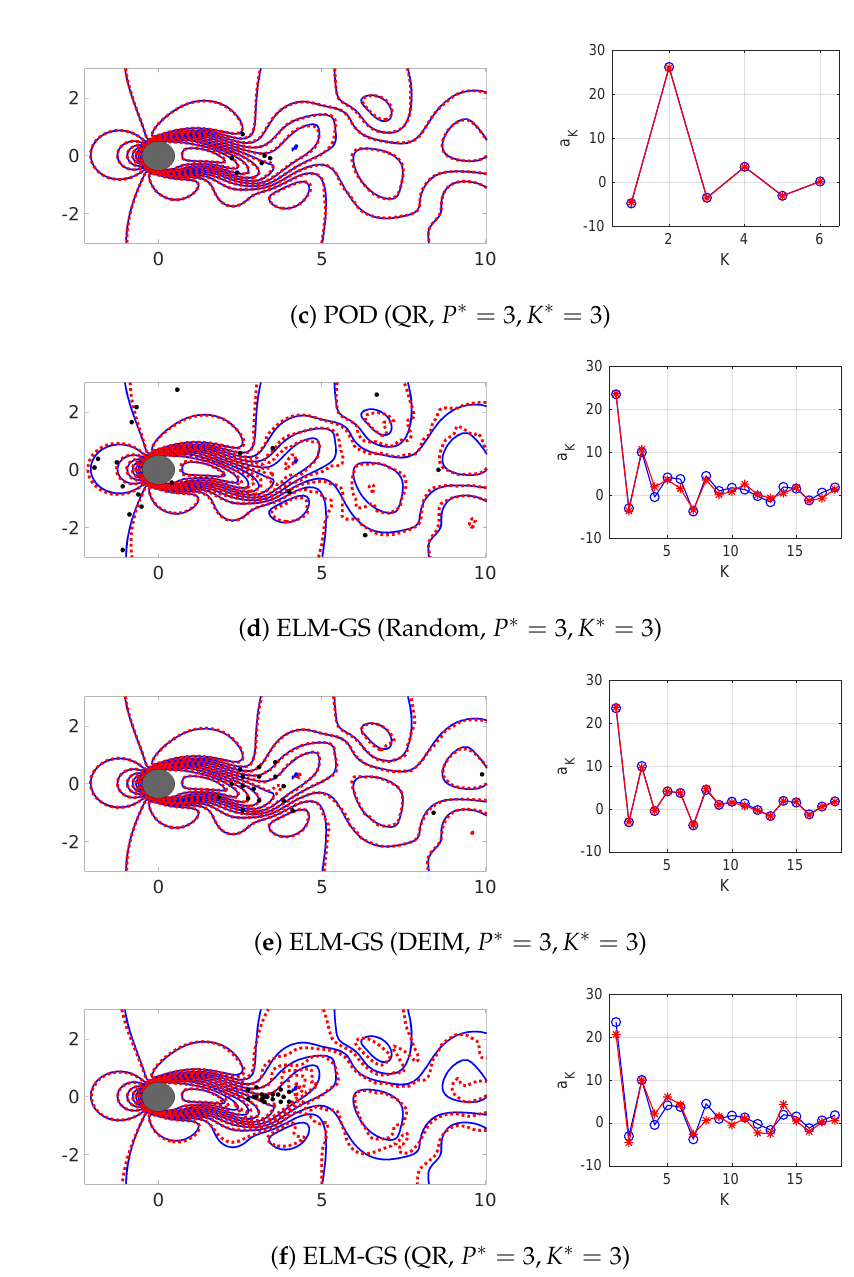
Figure 15. Left column: Comparison of line contours of streamwise velocity between the true flow field (blue) and SR reconstruction (red) for Re = 100 using random and DEIM sensor placement at P ∗ = 3, K ∗ = 3 (marginally sampled) using both ELM-GS and POD SR. Right column: comparison of the estimated coefficients a using the entire data (blue circle) and the downsampled data (red star)